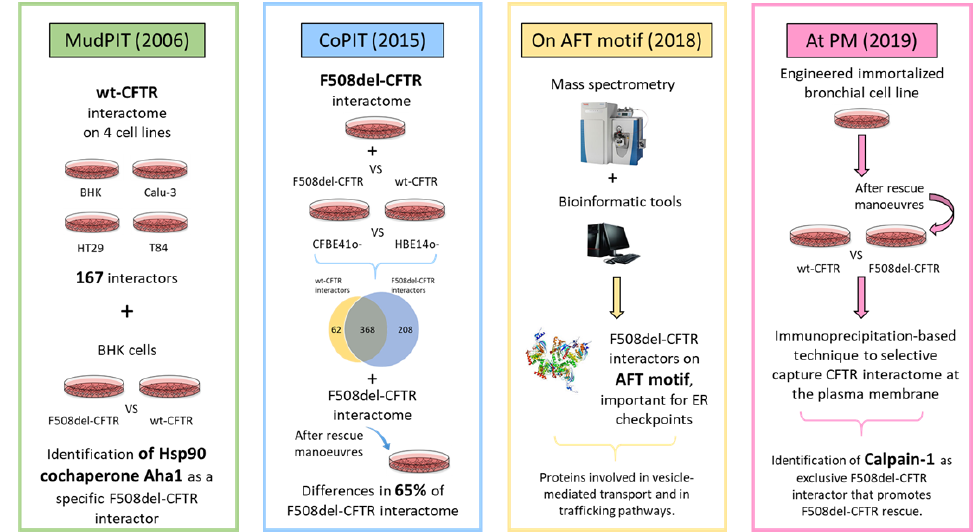
Figure 2. Summary and outcomes of four of the cystic fibrosis transmembrane conductance regulator (CFTR) interactomic experiments highlighted in this review.